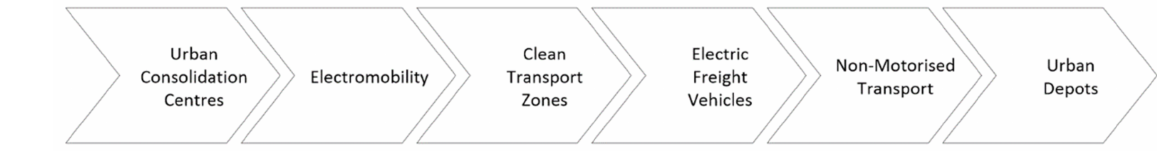
Figure 1. Issues addressed in the literature